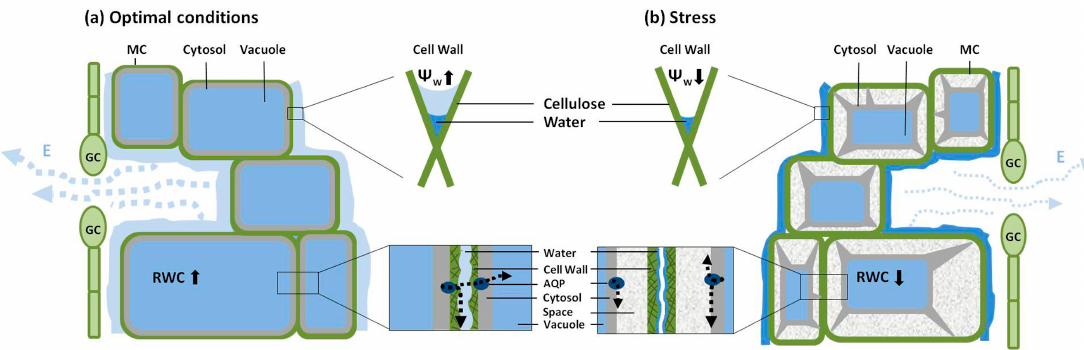
Figure 2. Mesophyll Cell (MC) turgor as a hydraulic fuse altering water path through the leaf. ( a ) When turgid, cells Plasmamembrane (PM) is in contact with cell wall so that water exiting trough AQP substantially wet cell wall, sustaining apoplastic water flow; ( b ) When water statues is low, plasmolysis cause distancing of PM from cell wall, and as a fuse, cuts off water supply to the cell wall. The negative water potential ( Ψ W , arrows indicate high or low) generated within the microcapillary structure of the mesophyll cell walls serves as a transpiration (E) pump pulling water from the xylem [80]. This negative water potential is highest (absolute value) next to the mesophyll membrane and may serve as a pump (i.e., difference in water potentials between the cell wall and the protoplast) resulting in water leaving the cell until physical disconnection between the protoplast and its wall, at which point no further reduction in Relative Water Content (RWC, arrows indicate high or low) is observed. The water which evaporates from the cell wall leaves the leaf via the Guard Cells (GC).